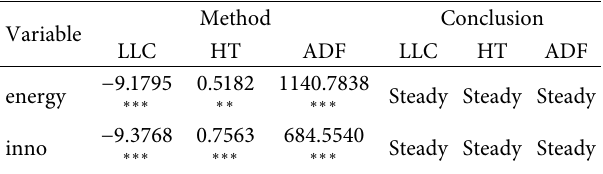
Table 4: Stability test of the PVAR (2) model.